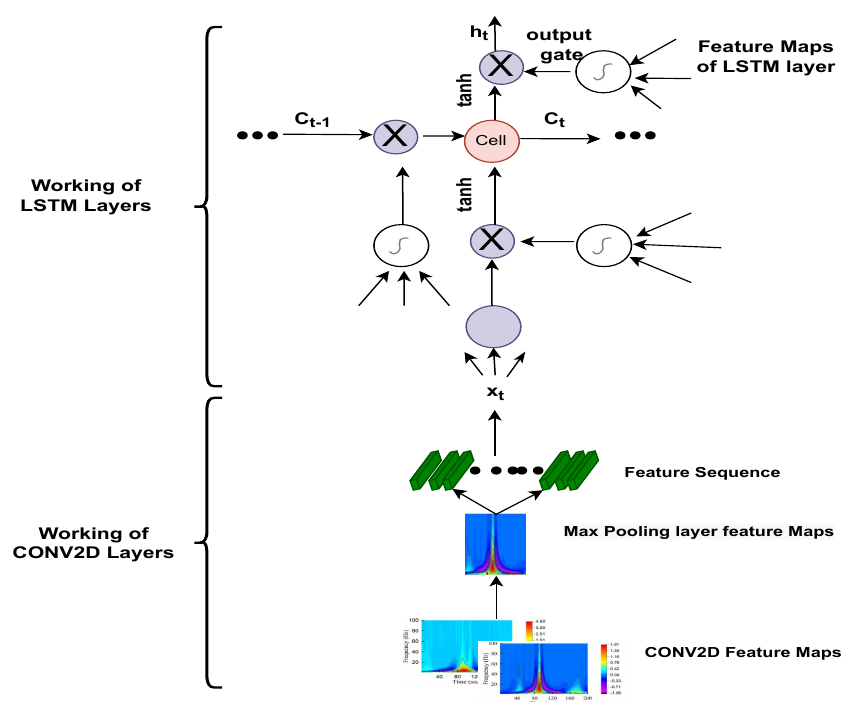
Figure 9. Internal components of the proposed 2D-CNN-LSTM